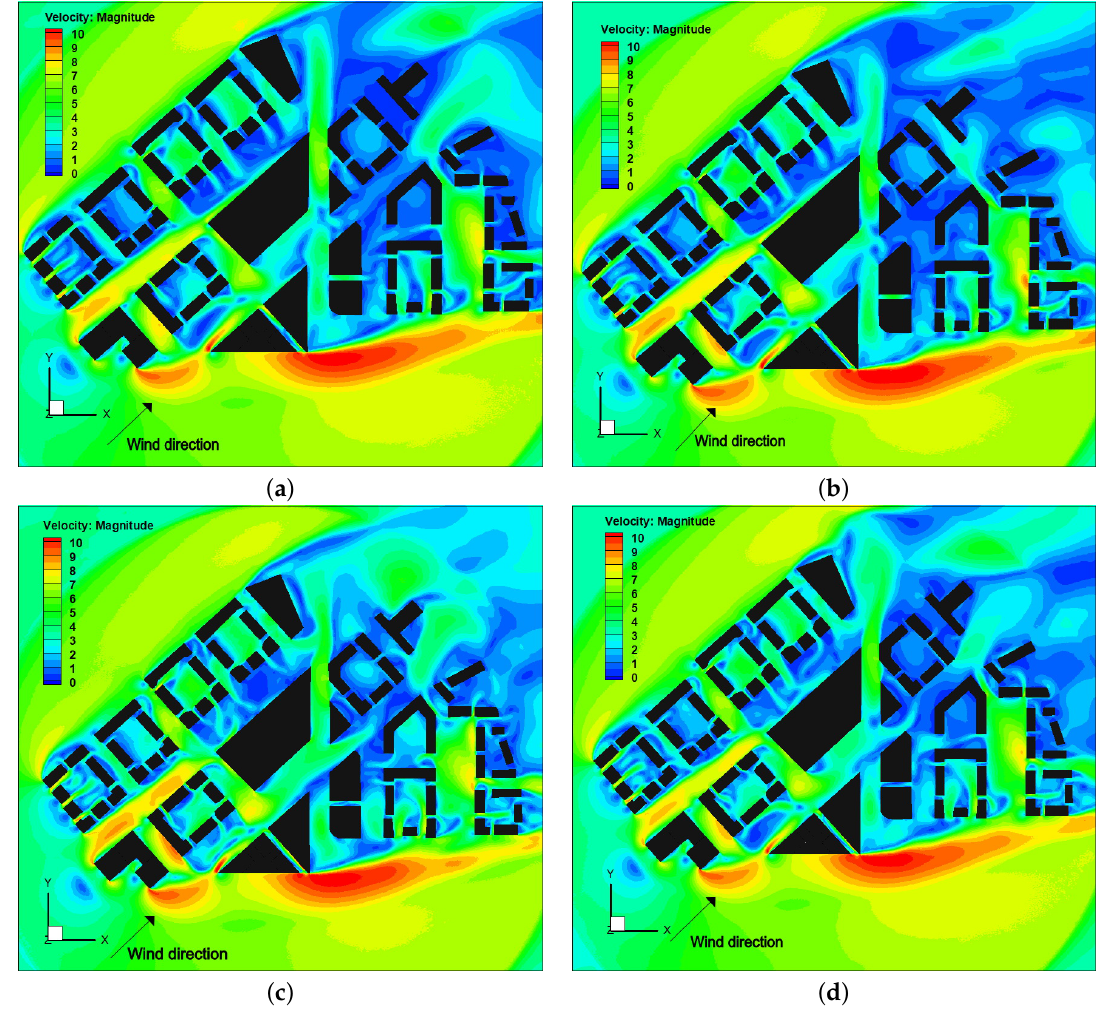
Figure 6. Contours of the velocity magnitude: ( a ) standard k- ε , ( b ) realizable k- ε , ( c ) k- ω , ( d ) SST k- ω .